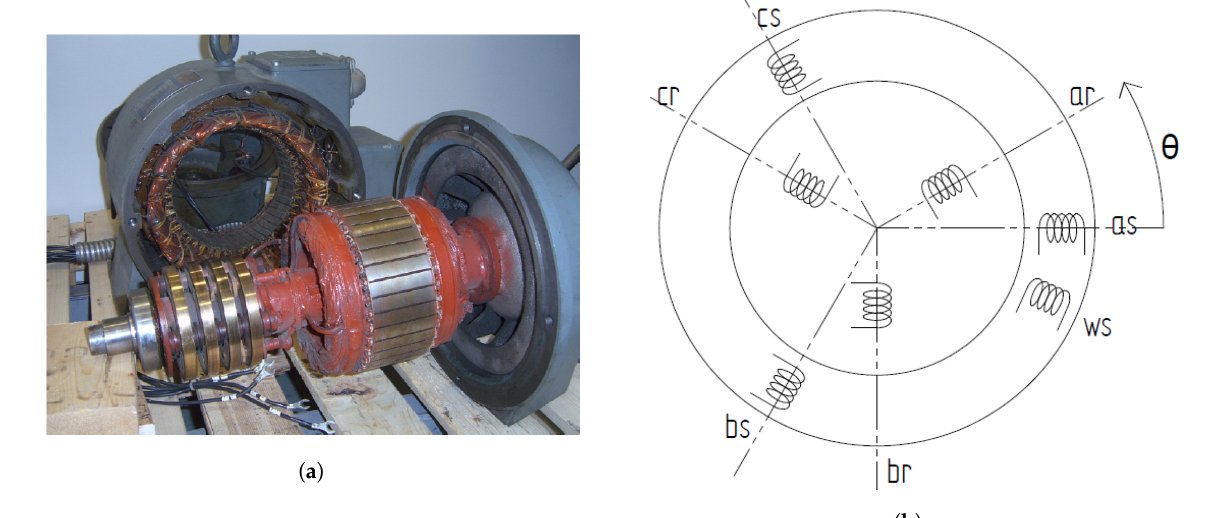
Figure 1. ( a ) Photo of the wound rotor induction machine (WRIM) showing its stator and rotor; ( b ) circuits of the WRIM used to build the